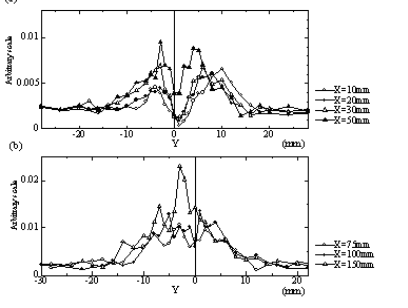
Fig. 17 Amplitude distribution of 1/4 subharmonics (with 14Hz forcing);(a)